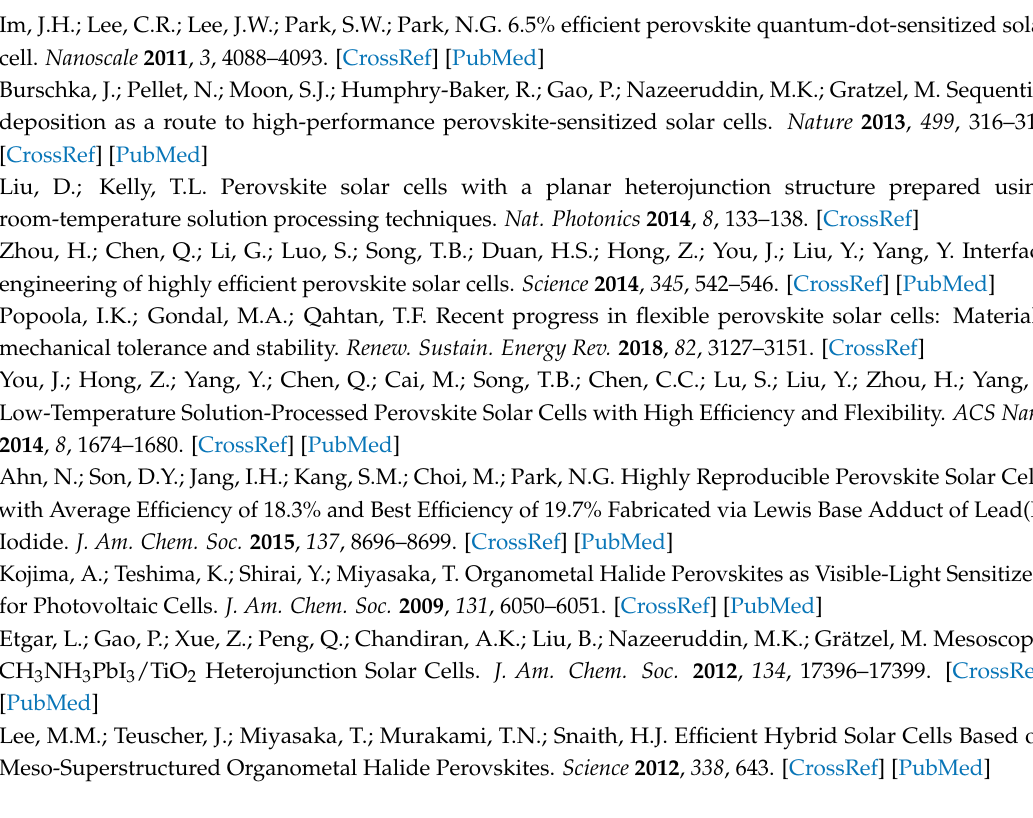
fullerene material (C 60 , blue curve), in the inverted perovskite solar cells from 400–850 nm, Figure S2: The AFM measurement result for the PSCs with specific tilt angle (X-Y-Z of − 40 ◦ − 30 ◦ − 30 ◦ ) and scan area (5 × 5 µ